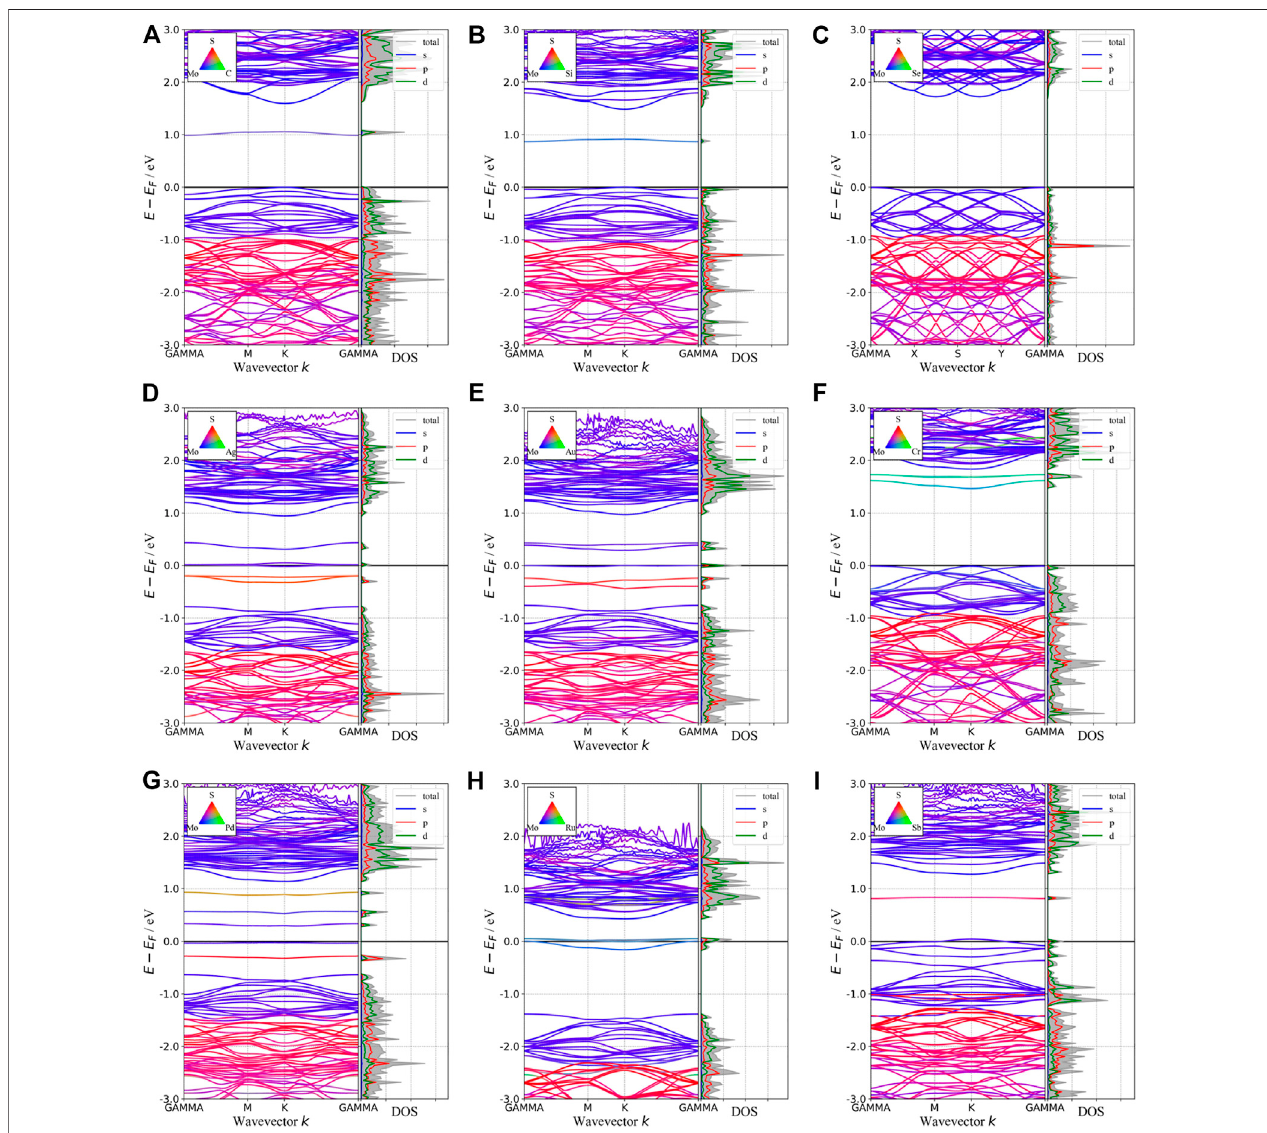
FIGURE11| BandstructuresandpDOSofmonolayer2H-MoS 2 afterdopingwithdifferentforeignatoms.Thetypeofdopedatomsisindicatedbythecolormapin the upper left corner of each plot.